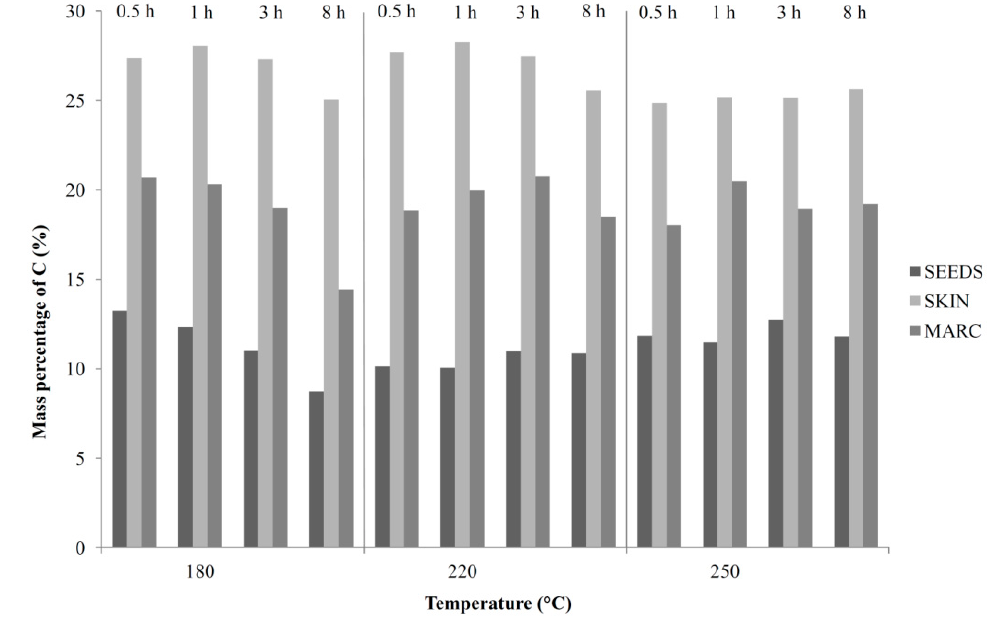
Figure 3. Mass percentage of carbon in the liquid phase.